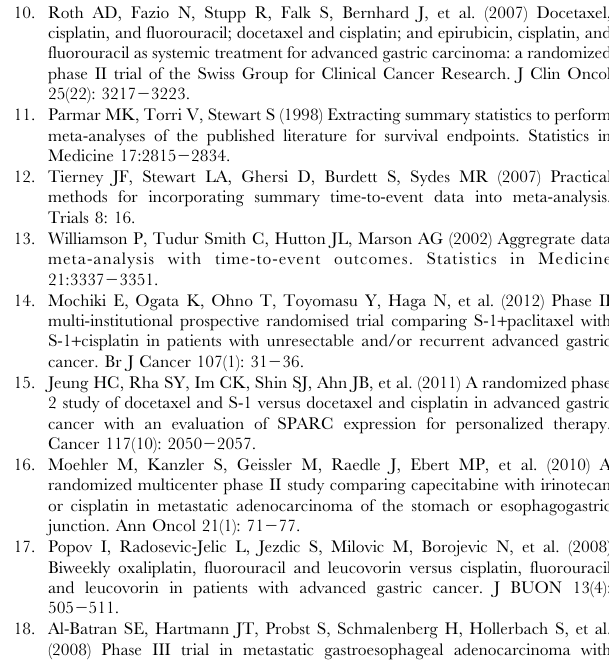
Figure S2 Meta-analysis of overall survival. Figure S3 Meta-analysis of progression-free survival. Figure S4 Meta-analysis of reponse rate. Figure S5 Funnel plot for publication bias. Table S1 Characteristics of included